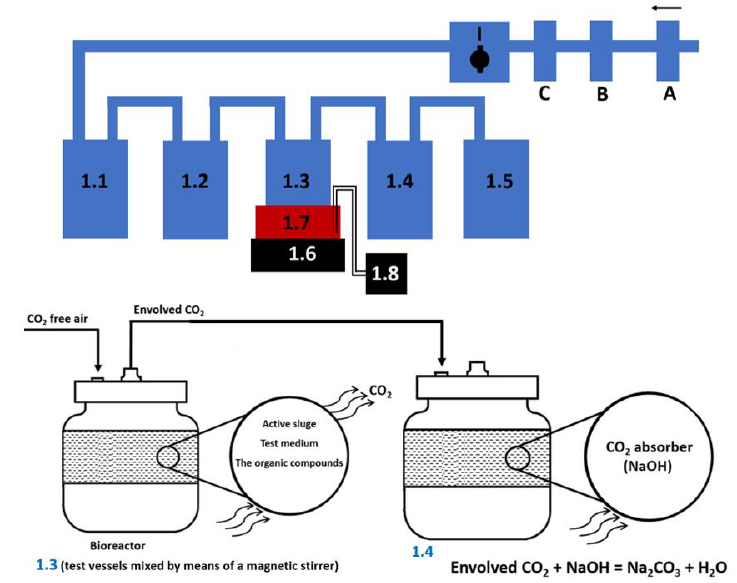
Figure 3. The test system to measure carbon dioxide.